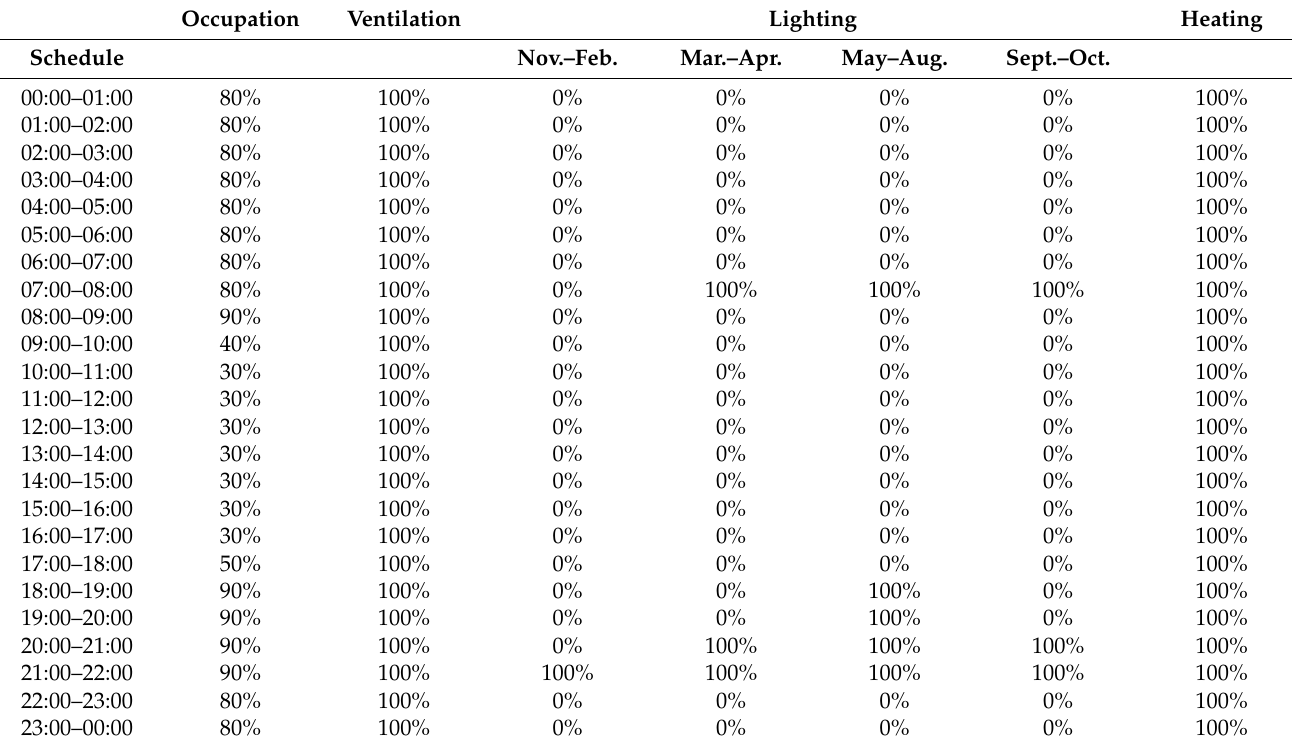
Table A4. Monthly, daily, and hourly load